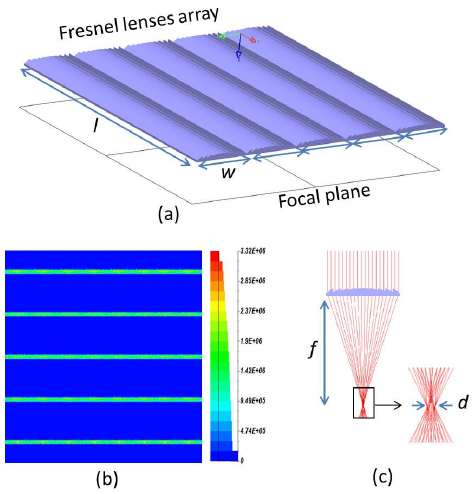
Figure 3. ( a ) Linear Fresnel lenses array; ( b ) Light distribution on the focal plane; ( c ) Ray tracing of sunlight beam passing through a Fresnel lens. sunlight beam passing through a Fresnel